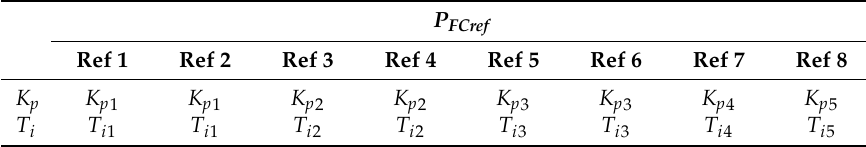
Table 1. Rules for fuzzy logic controller.